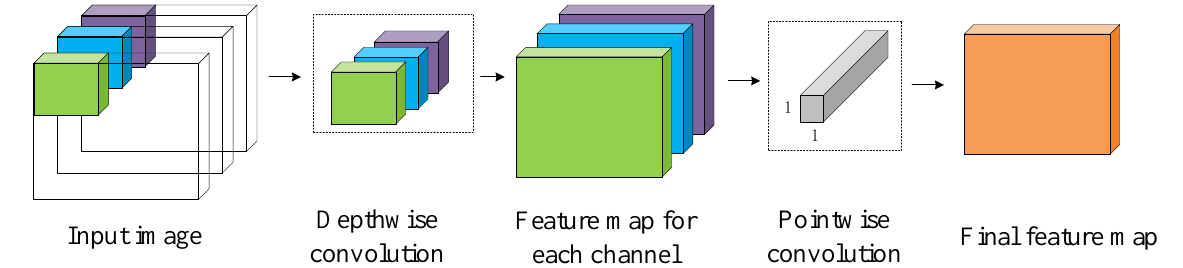
Figure 4. Depthwise separable